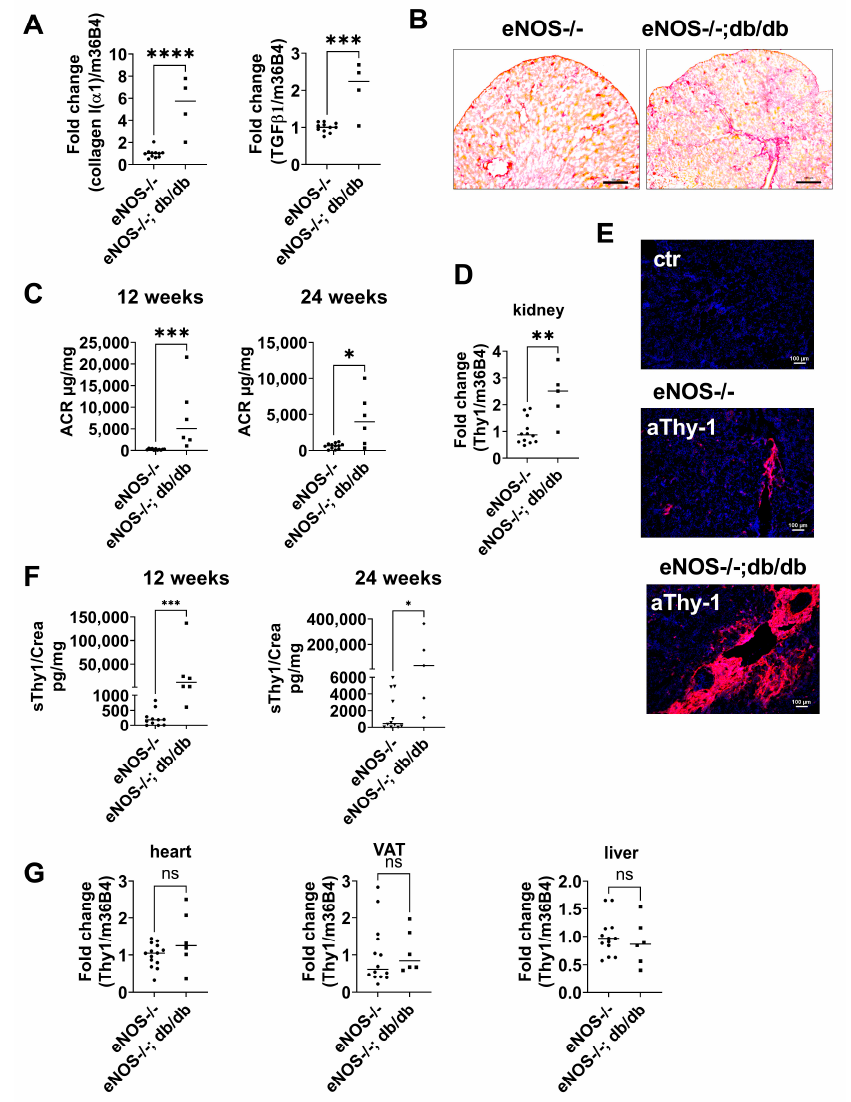
Figure 2. Thy-1 is upregulated in a mouse model of chronic kidney disease (CKD) due to diabetic nephropathy compared with non-diabetic control mice. ( A ) Relative collagen type I ( α 1) and TGF β 1 gene expression in the kidney of CKD (eNOS − / − C57BLKS db/db mice) and control mice (eNOS − / − C57BLKS) detected by qPCR at the age of 24 weeks. ( B ) Detection of collagen by Picro Sirius red staining in tissue sections of CKD and control mice. One representative example of four mice is shown. bar = 500 µ m. ( C ) Urinary albumin to creatinine ratio (ACR) in spot urine samples of 12- and 24-week-old CKD and control mice. ( D ) Relative Thy -1 gene expression in kidney detected by qPCR. ( E ) Thy-1 protein expression in kidney detected by immunofluorescence labelling with anti-Thy-1 antibody (red). Nuclei (blue) were counterstained with DAPI. Images represent one representative example of four different mice. ( F ) Urinary sThy-1/creatinine ratio in spot urine samples of CKD and control mice detected at the age of 12 and 24 weeks by ELISA. ( G ) Relative Thy -1 gene expression in heart, liver, and visceral adipose tissue (VAT) detected by qPCR. Results are shown as mean ± standard deviation. The p -values were assessed by unpaired Student’s t -tests. Each point represents one mouse. * p < 0.05; ** p < 0.01; *** p < 0.001, **** p < 0.0001. bar = 100 µ